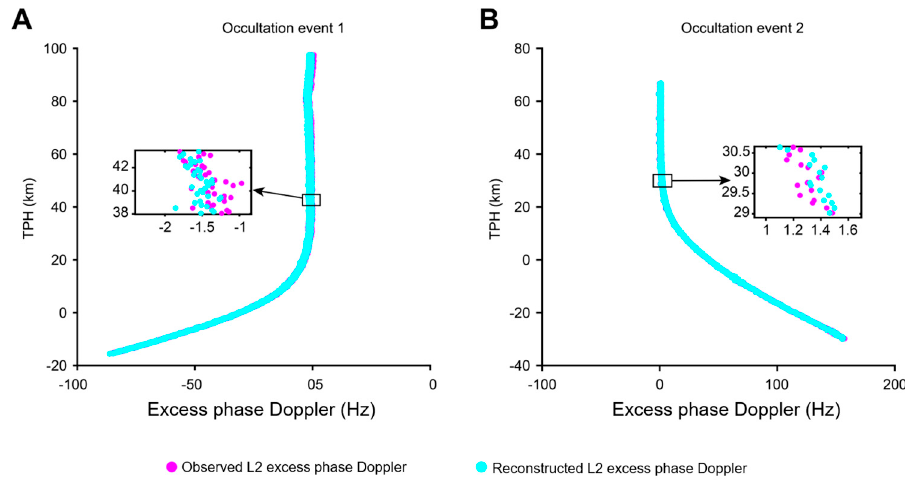
Figure 4. The comparison between the excess phase Doppler of reconstructed B 3* and that of the actual observation B 3 , ( A ) is occultation event 1 and ( B ) is occultation event 2.